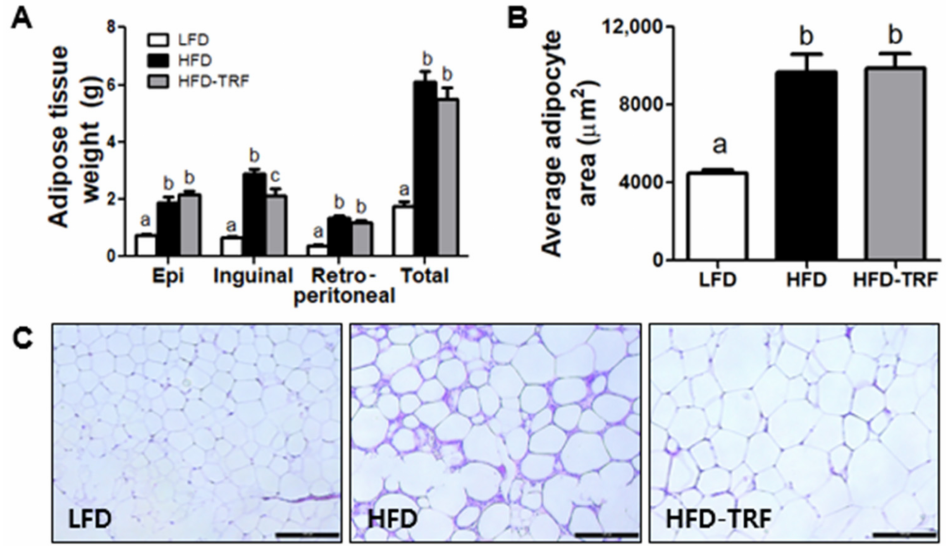
Figure 2. Effects of time-restricted feeding (TRF) on adipose tissue. C57BL/6 mice were fed a low-fat diet or high-fat diet ad libitum (LFD and HFD, respectively) for 14 weeks. Time-restricted feeding was started after 6 weeks of ad libitum consumption of a high-fat diet. ( A ) Fat distribution: epididymal adipose tissue, inguinal subcutaneous adipose tissue, retroperitoneal adipose tissue; ( B ) average adipocyte size area; ( C ) representative H&E-stained histological sections of epididymal adipose tissue in the LFD, HFD, and HFD-TRF groups. Scale bar, 100 µ m. Data are presented as mean ± SEM ( n = 7). a,b,c Different superscripts indicate significant difference at least at p < 0.05 by ANOVA with Tukey’s post hoc